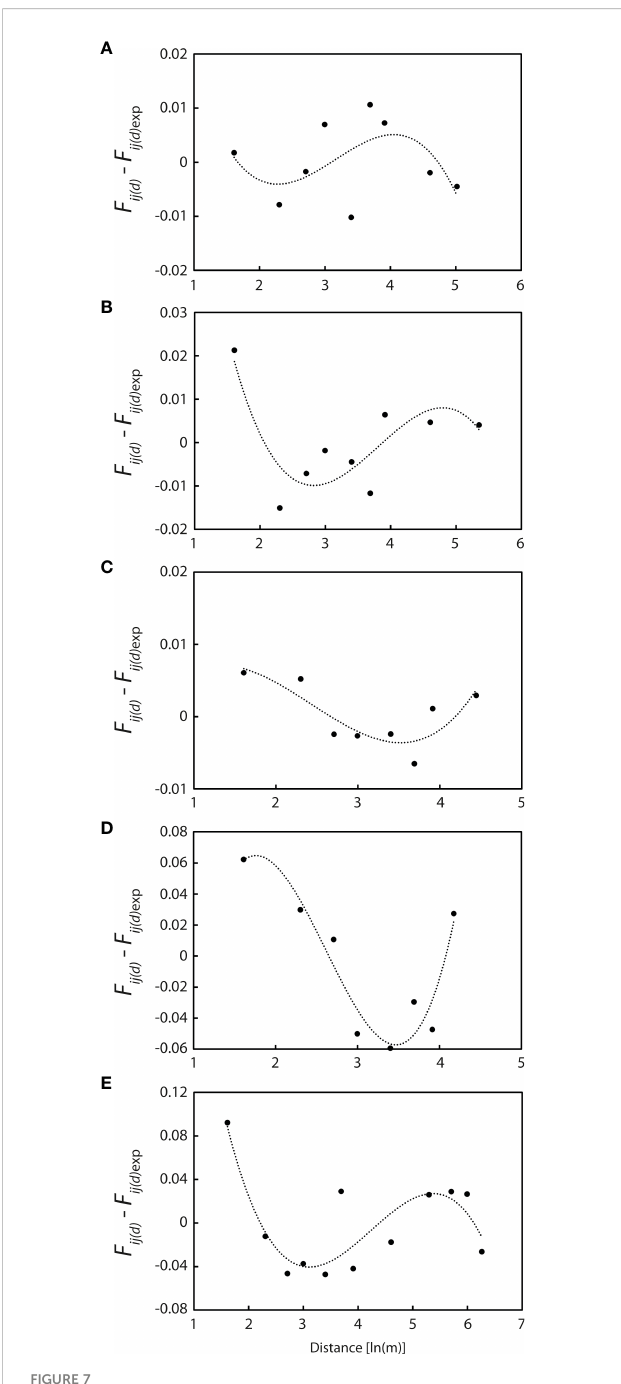
FIGURE 7 Polynomial regression curves of the third power of residuals [ F ij ( d ) - F ij ( d ) d ) for the fi ve populations with more than 20 individuals. exp ] on ln ( (A) WX1 (n = 56). (B) WX2 (n = 39). (C) WX3 (n = 60). (D) NPA2 (n = 40). (E) PXH1 (n = 23). All curves are concave at short log distances, indicating that gene fl ow via seed is more restricted than that via